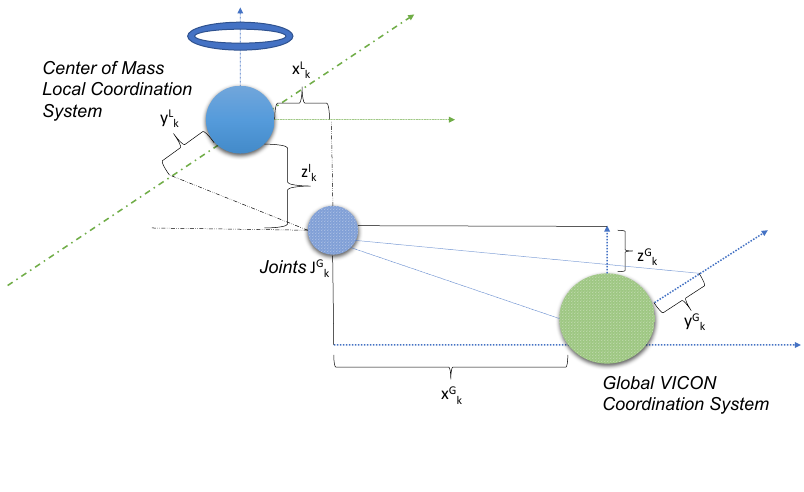
Figure 8. VICON global coordination system being transformed to a local coordination system. Its center is the center of mass of the dancer [21]. This allows for compensation of the dancer spatial